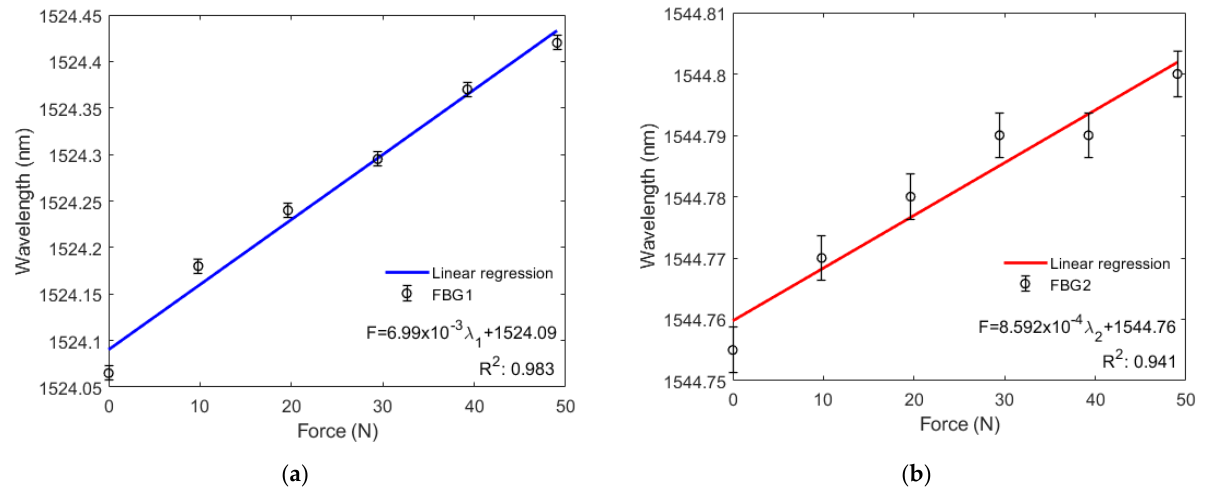
Figure 6. ( a ) Bragg wavelength shift as a function of the compression force for FBG1; ( b ) Bragg wavelength shift as a function of the compression force for FBG2.